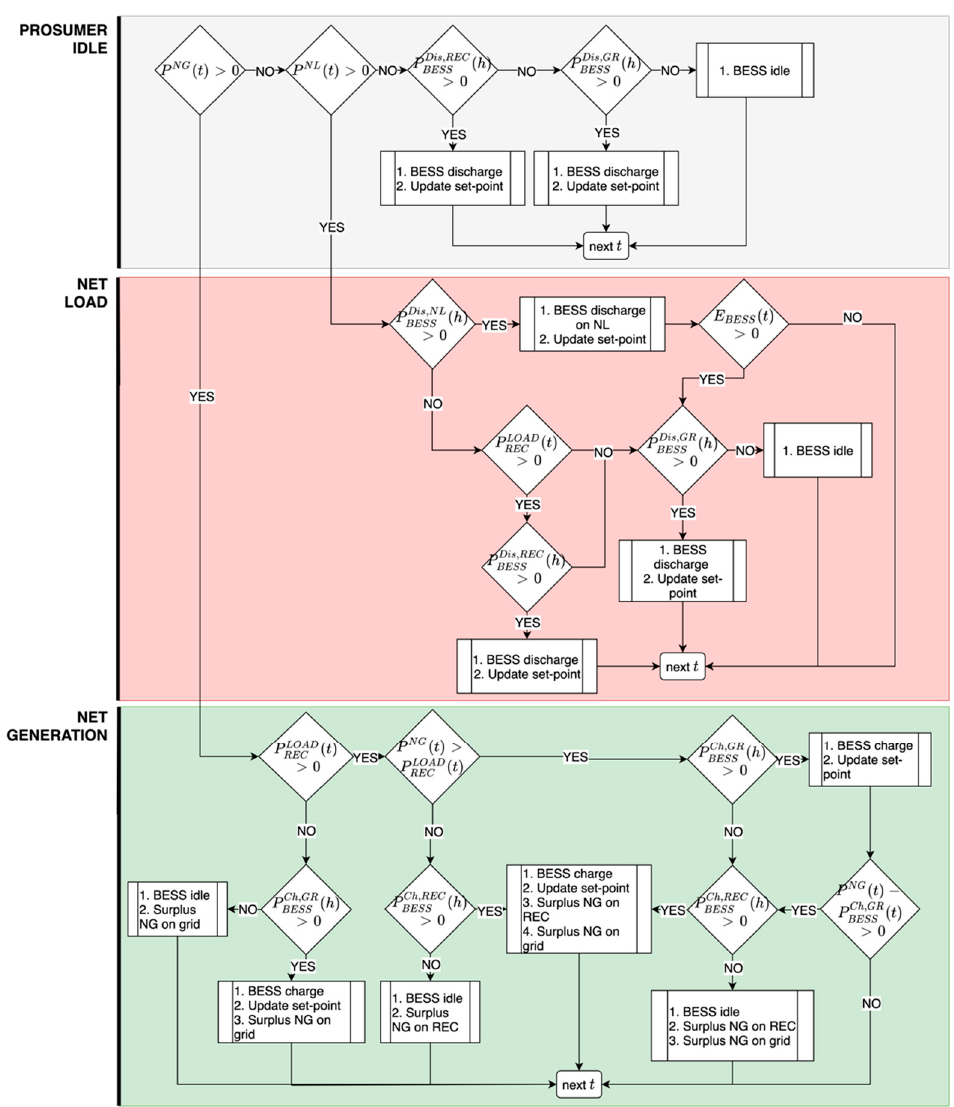
Figure 6. Decision tree algorithm flowchart.